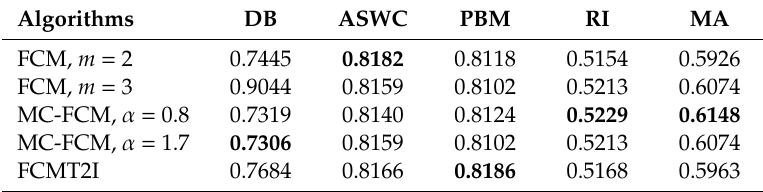
Table 3. Experimental results with the HEART dataset, 303 samples, 2 clusters, m L = 1.1, m U = 4.1.